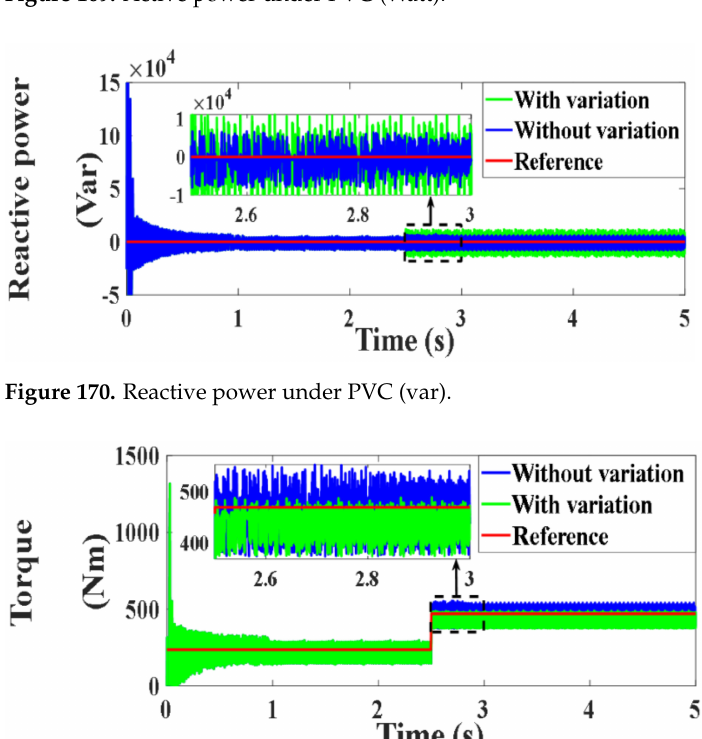
Figure 169. Active power under PVC (Watt).